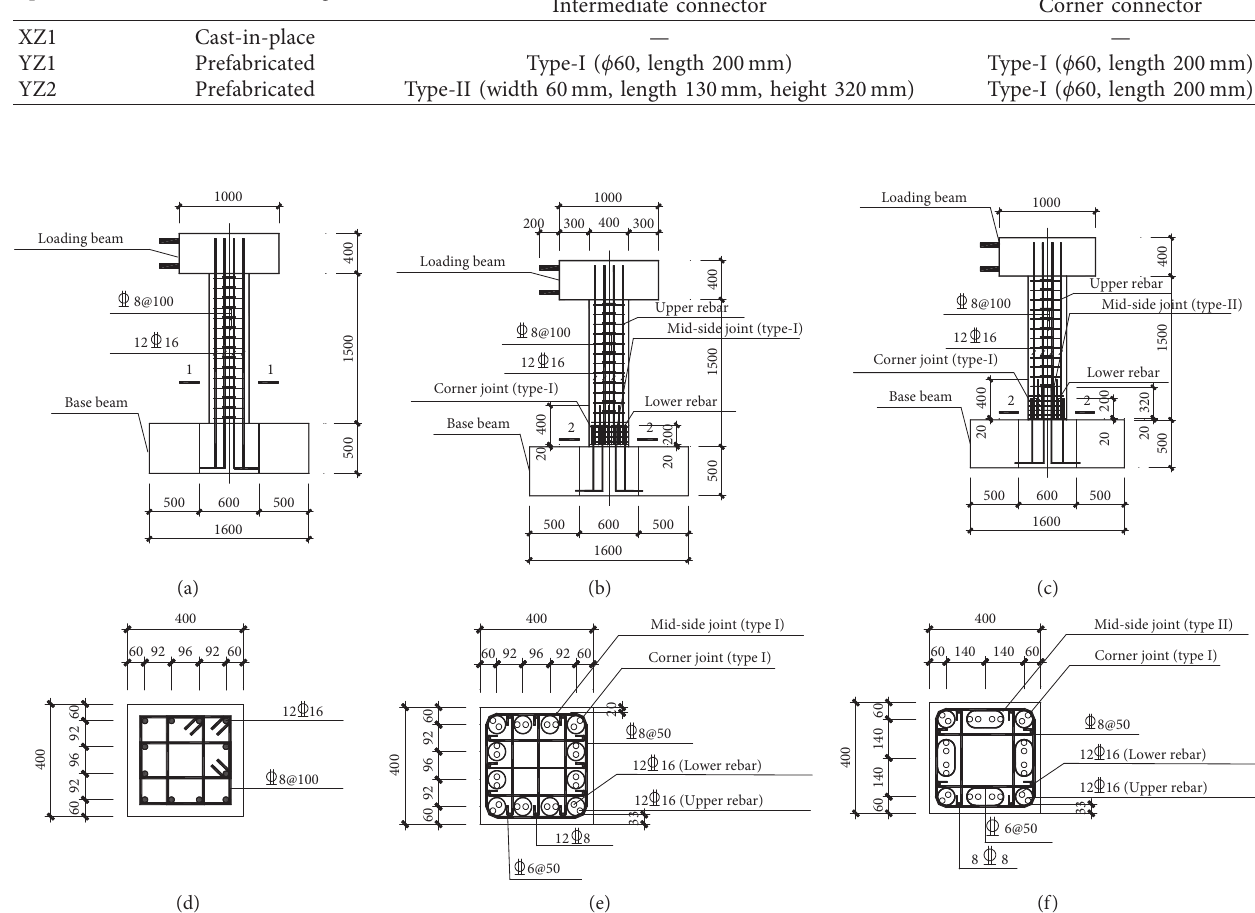
Figure 2: Details of column-base joints. (a) Front elevation of XZ1. (b) Front elevation of YZ1. (c) Front elevation of YZ2. (d) Section 1-1 of